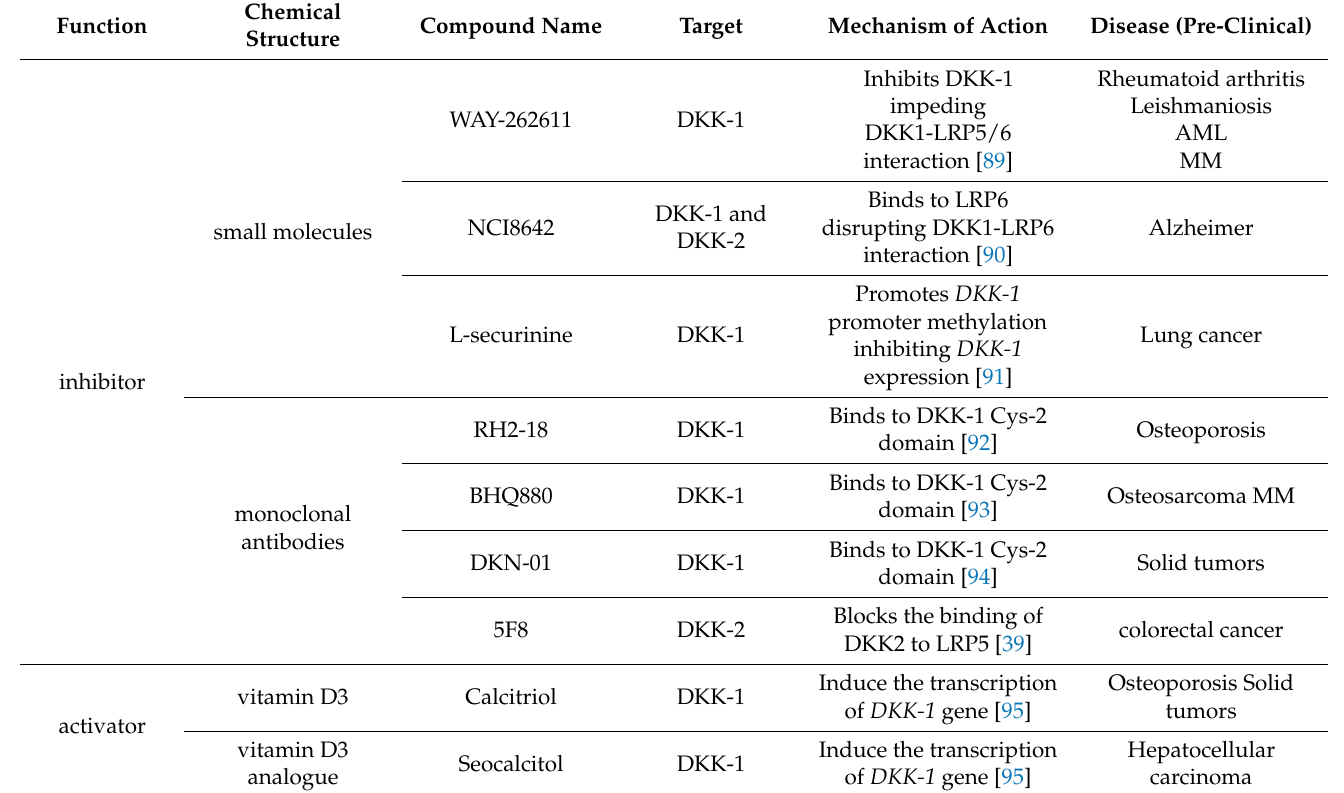
Table 2. Compounds targeting DKK